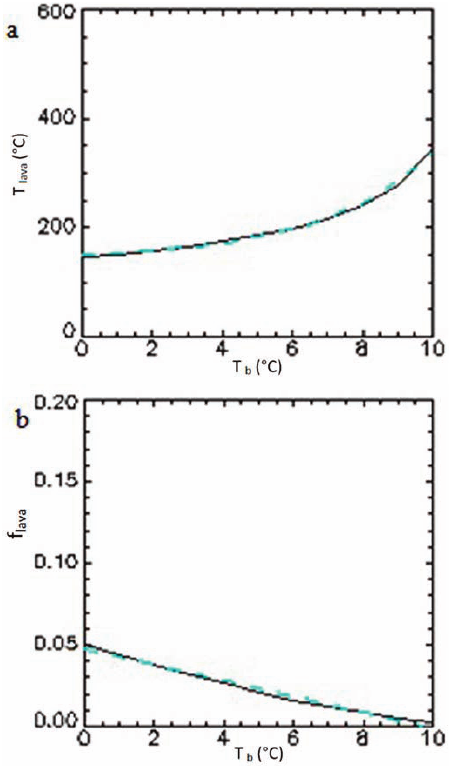
Figure 9. (a) T and (b) f trends as functions of T , for a radiant pixel lava lava b on the AVHRR image of Mount Etna on October 30, 2006. Black solid line, solution from the dual-band fit; blue dashed line, solution from the logarithmic linear fit.